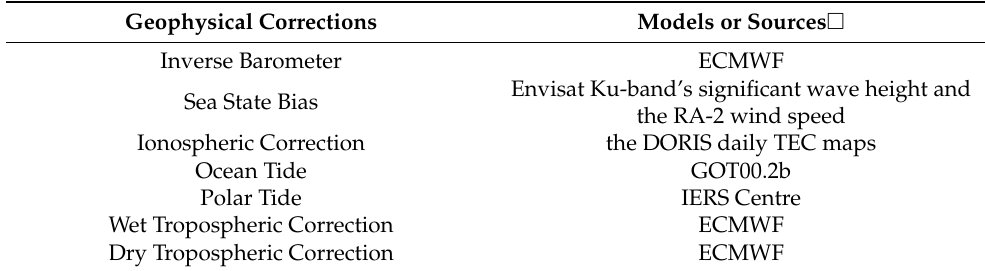
Table 2. Models and data sources used for geophysical corrections in Geophysical Data Record (GDR)